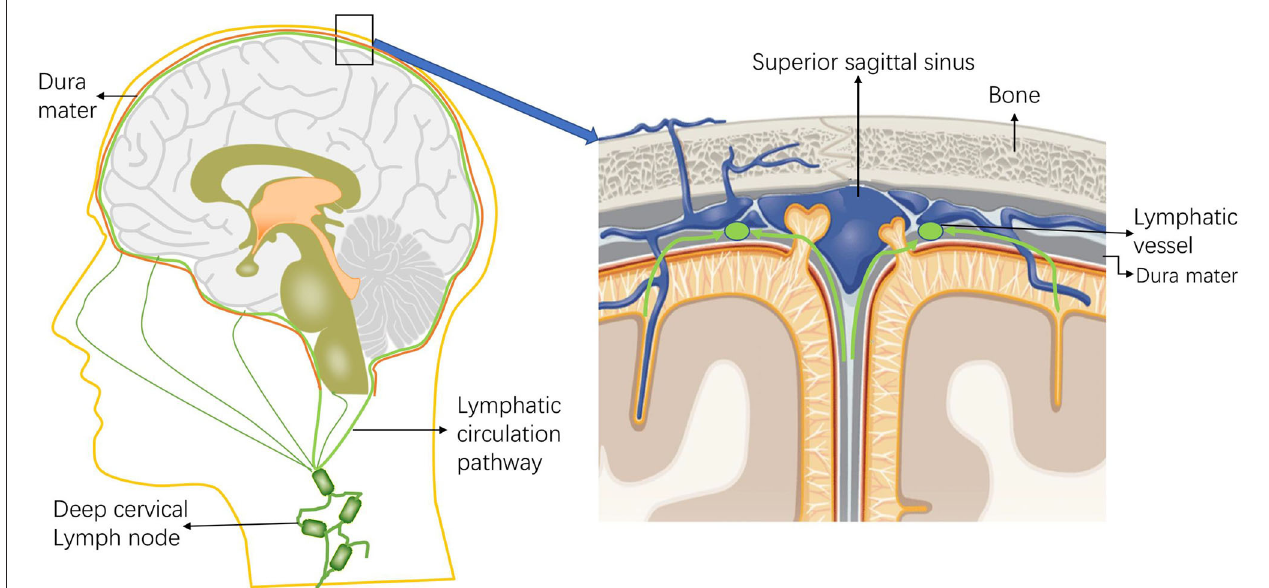
FIGURE 2 | Schematic diagram of the intracranial lymphatic circulation and the location of the meningeal lymphatic vessels. Through the lymphatic system, the meningeal lymphatics absorb cerebrospinal fluid (CSF) from the adjacent subarachnoid space and cerebral ISF, and the meningeal lymphatics can deliver CSF to the deep cervical lymph nodes through the foramina at the base of the